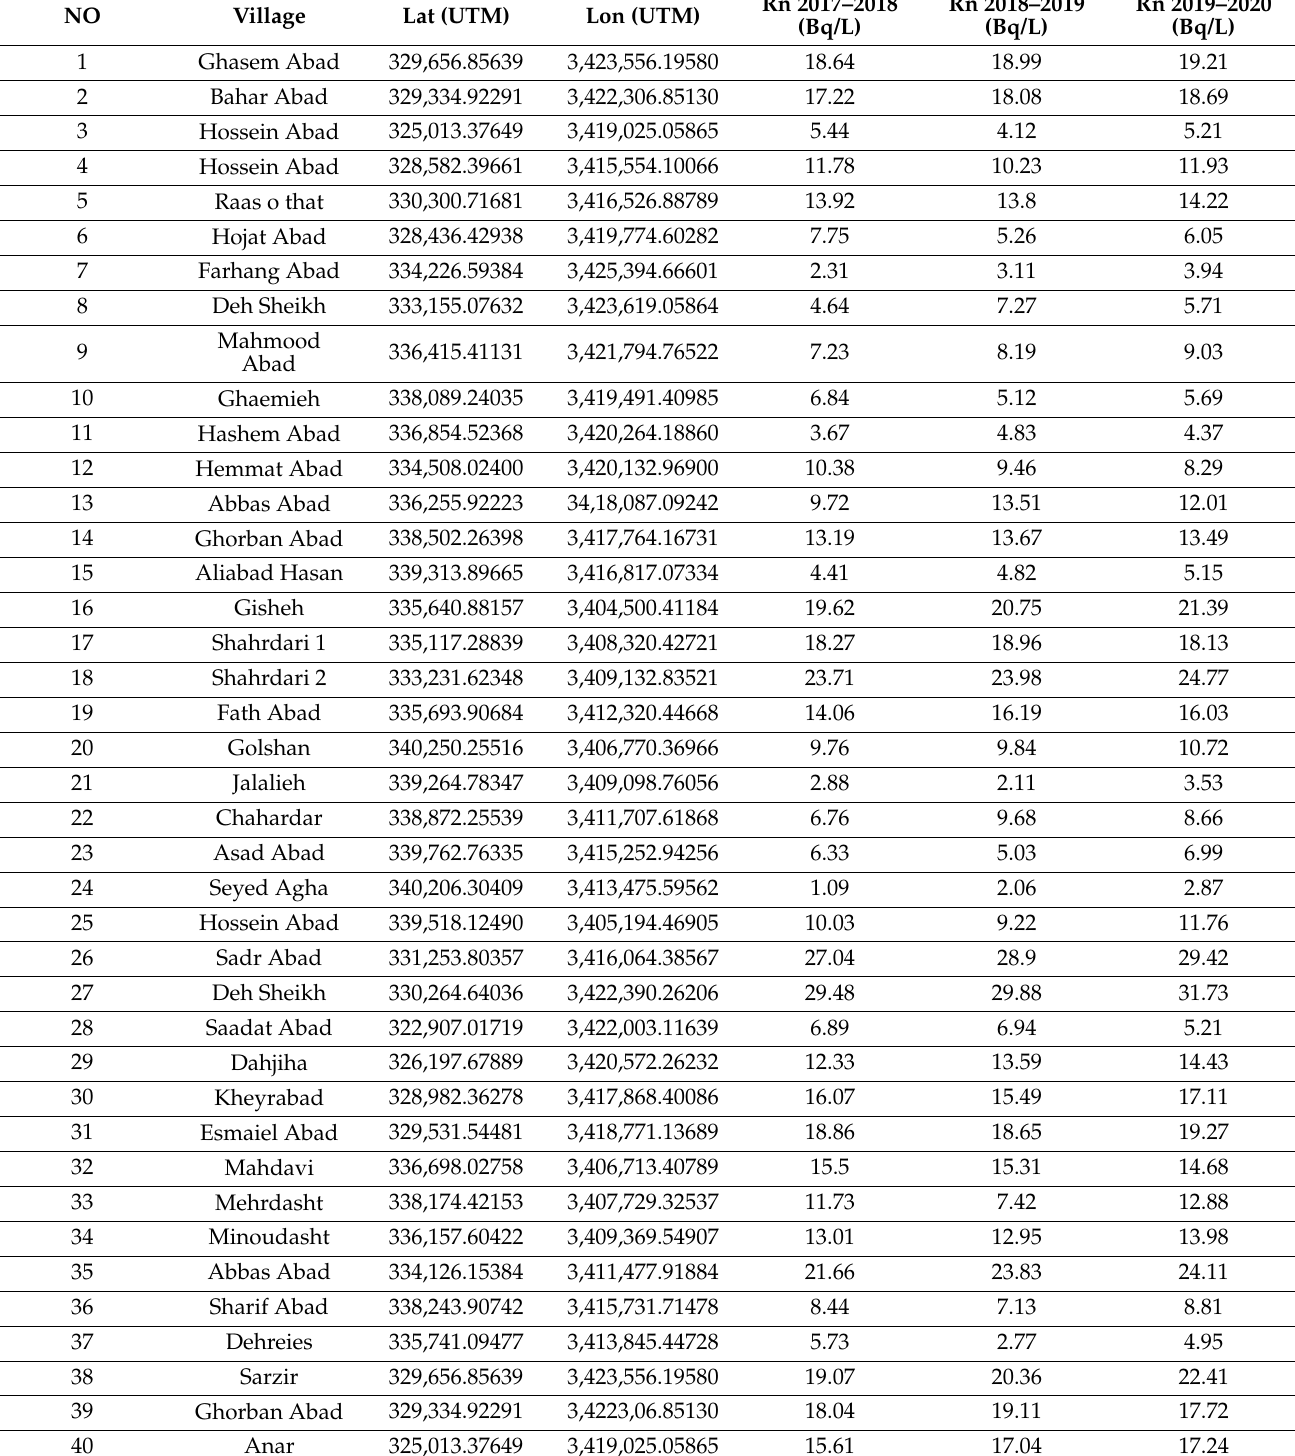
Table 2. Well information and radon concentration of the groundwater samples from March 2017 to May 2020. NO